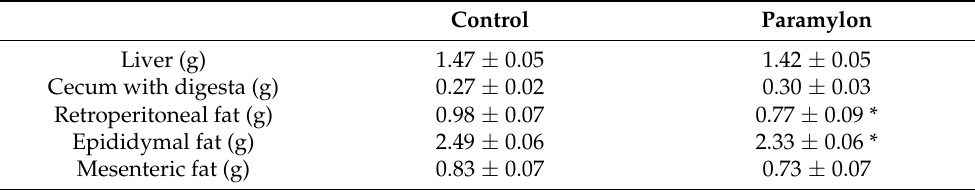
Table 3. Weight of organs.